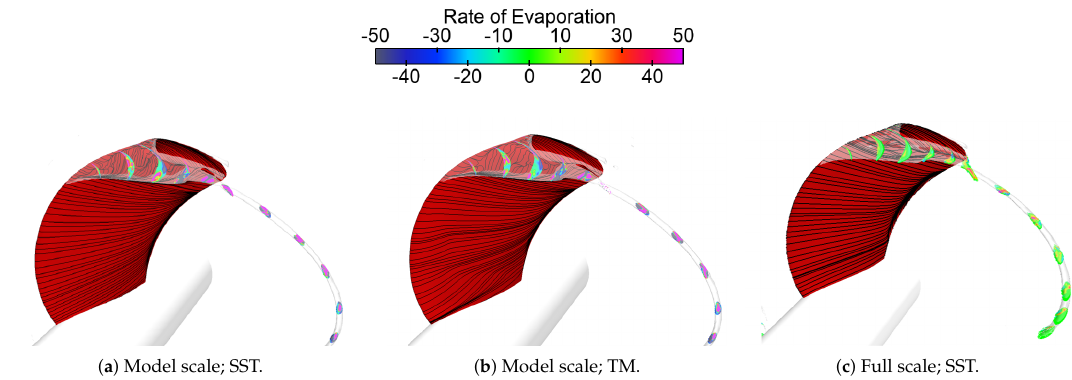
Figure 30. Rate of evaporation [kg/m 3 s] within the cavity volume in model and full scale for the TLP propeller. Perspective views near one blade. Cavitation is shown as the grey transparent surface, and the surface-restricted streamlines on the blades as the black curves.